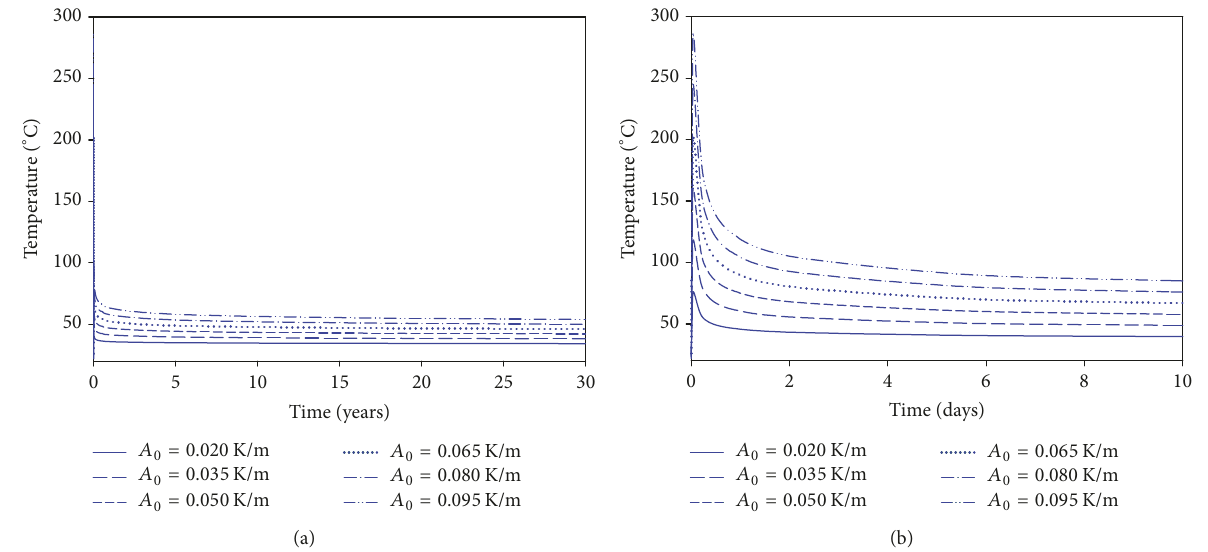
Figure 11: Variation with time of output temperature of the production well under different geothermal gradient A 0 : (a) for large time period and (b) for short time period.